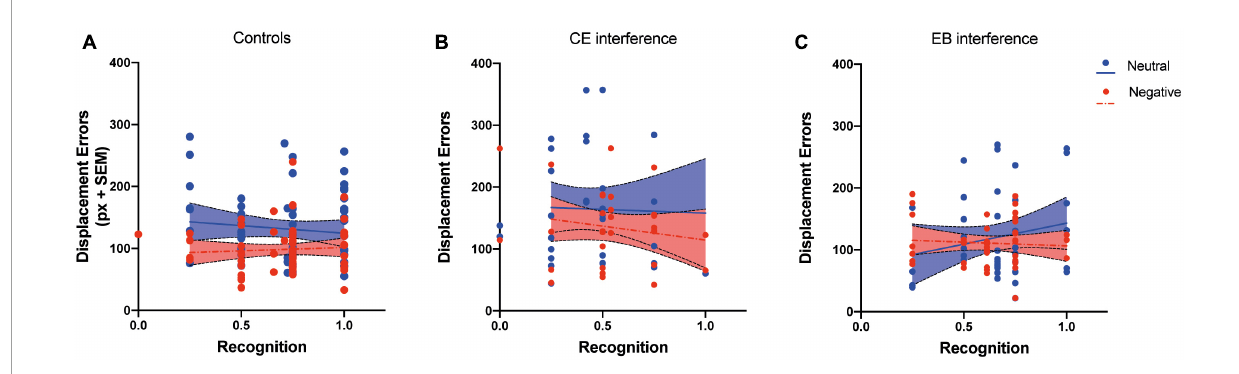
FIGURE3 Relationship between the rate of correctly recognized pictures (Recognition) and the displacement errors in Experiments 2 and 3. Separate regression analyses for negative and neutral pictures were performed for controls (A) , CE-interference (B) , and EB-interference (C) groups.